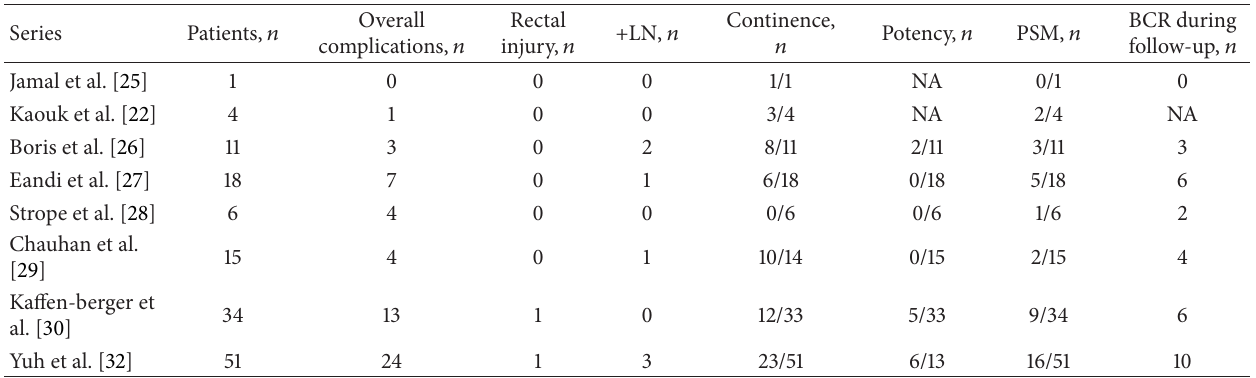
Table 2: Oncologic and functional outcomes in sRARP